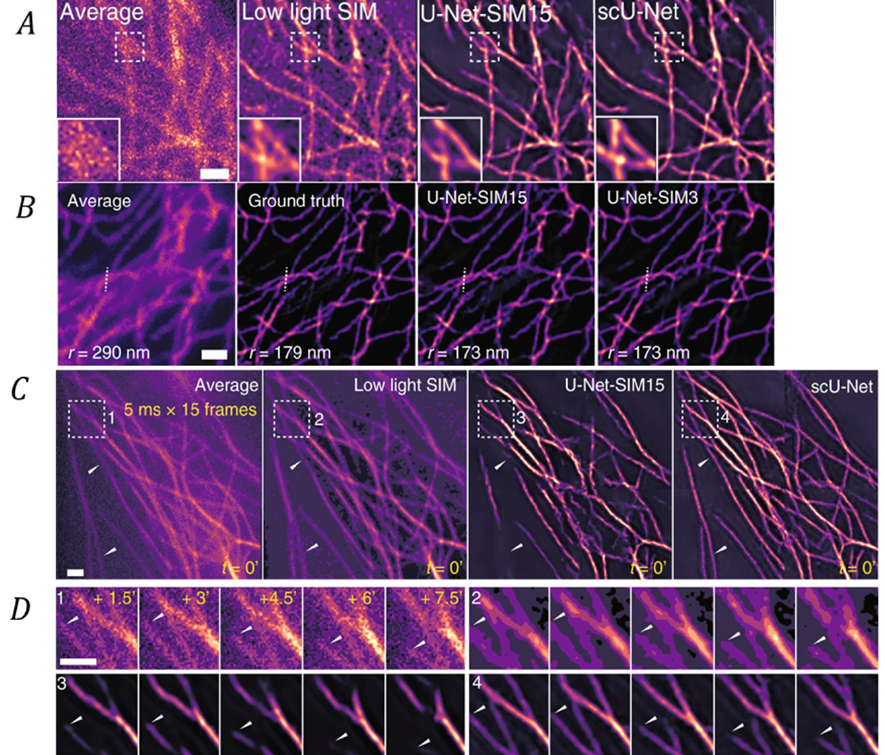
Figure 11. Correlative DL-SIM microscopy in the spatial domain [113]. ( A ) Left to right: U-Net recon- struction results for microtubules. Average projections of 15 SIM raw data images, SIM reconstruction results, U-Net-3 SIM output, and U-Net SIM-15 output; r indicates the resolution. ( B ) Left to right: scU-Net reconstruction results for microtubules under low-light conditions. Average projections of 15 SIM raw data images, SIM reconstruction results, scU-Net-3 SIM output, and scU-Net-15 SIM output. ( C ) DL-SIM reconstruction results for microtubules in living cells. scU-Net can resolve sample structures that cannot be resolved using U-Net. ( D ) Expanded views of features highlighted by the white arrows in C. Scale bar: 1 µ m. Copyright 2020 Nat